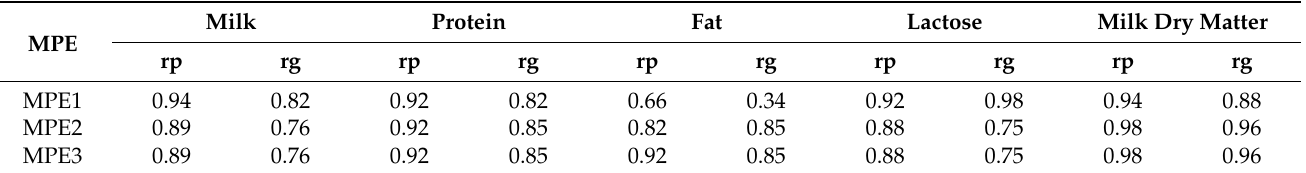
Table 4. Phenotypic (rp) and genetic (rg) correlations of predicted methane with milk and milk composition traits in each methane prediction equation